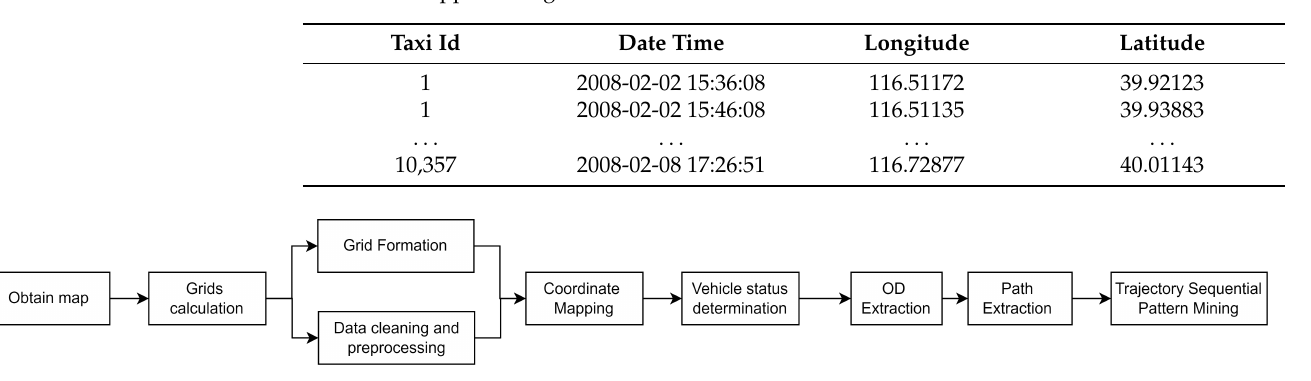
Table 2. A snippet of original Microsoft T-drive dataset.